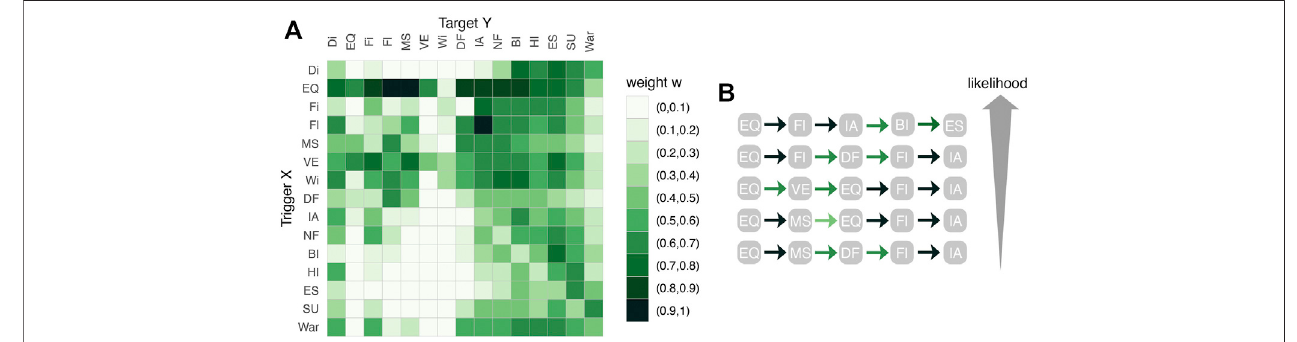
FIGURE 4 | (A) Weighted matrix based on participant input using the data from Mignan et al. (2016); (B) Top-5 chains-of-5-events modelled from the matching adjacencymatrix(Di:disease,EQ:earthquake,Fi: fi re,Fl: fl ood,MS:massslide,VE:volcaniceruption,Wi:windstorm,DF:damfailure,IA:industrialaccident,NF:network failure,BI:businessinterruption, HI:healthinterruption, ES: economic slowdown, SU: socialunrest – followingthenomenclature ofMignanet al.,2016).The topcascade derived from the present adjacency matrix is: an earthquake triggers a tsunami, which in turn leads to an industrial accident. It follows some business interruption and later some economic